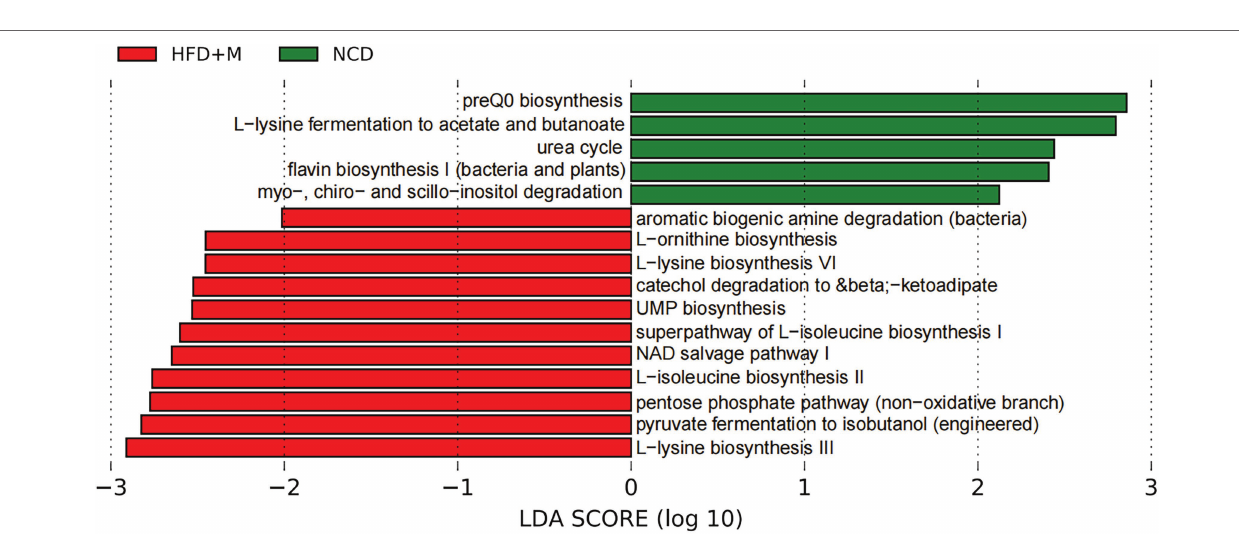
FIGURE 9 | LEfSe analysis of microbial functions predicted by PICRUSt in different rat groups. NCD, Normal Chow Diet rats; HFD, HFD rats; HFD + M, HFD rats received fecal microbiota transplant from HFD-T monkeys; LDA, linear discriminant analysis (LDA); LEfSe, linear discriminant analysis effect